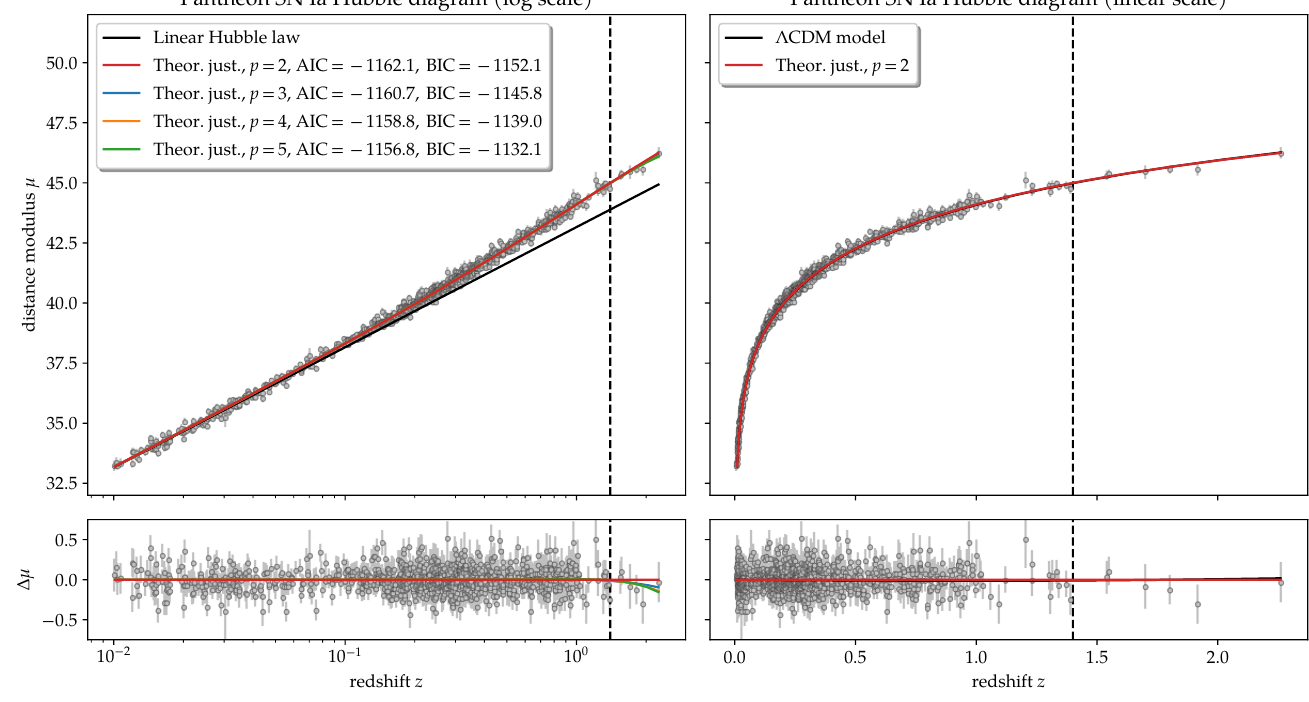
Figure 3. The result of fitting the Pantheon SN Ia data by the theoretically justified function. The model with p = 2 is chosen as the best one due to minimal Akaike information criterion (AIC) value and minimal Bayesian information criterion (BIC) value. The vertical dashed line marks the redshift of z = 1.4, which is the upper bound for the near LGRBs used to calibration. The interpolated distance–redshift relation would be used only for the LGRBs up to this border. Usually, polynomials of degree 1 or degree 2 are used for HD approximation, e.g., [19]. We chose the model with p = 2, because it minimises the Akaike information criterion (AIC) [38]. We used the obtained estimates of the parameters and their covariance matrix to generate them from a multivariate normal distribution of the size of 10,000. The corner plot of this sample is shown in Figure 4. This sample will become useful later for the Monte-Carlo uncertainty propagation. These polynomial coefficients have no physical sense, as they just show the best fit of a cosmology received by model-independent redshift– distance